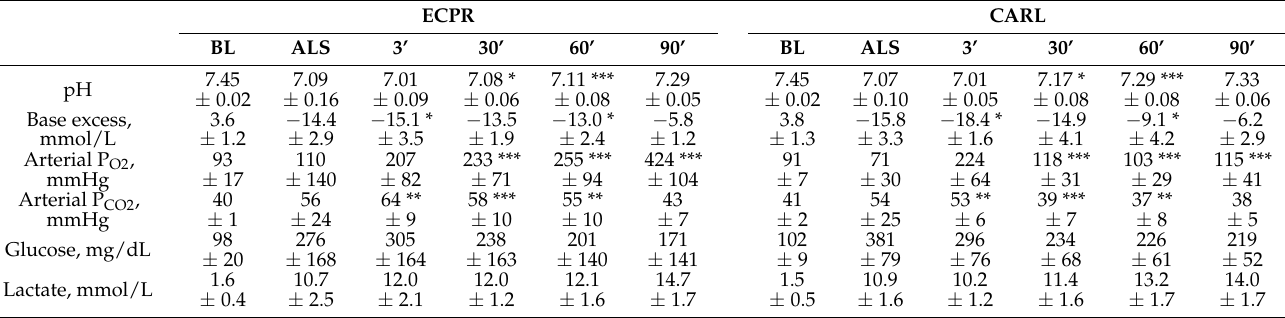
Table 2. Arterial blood gas analysis.